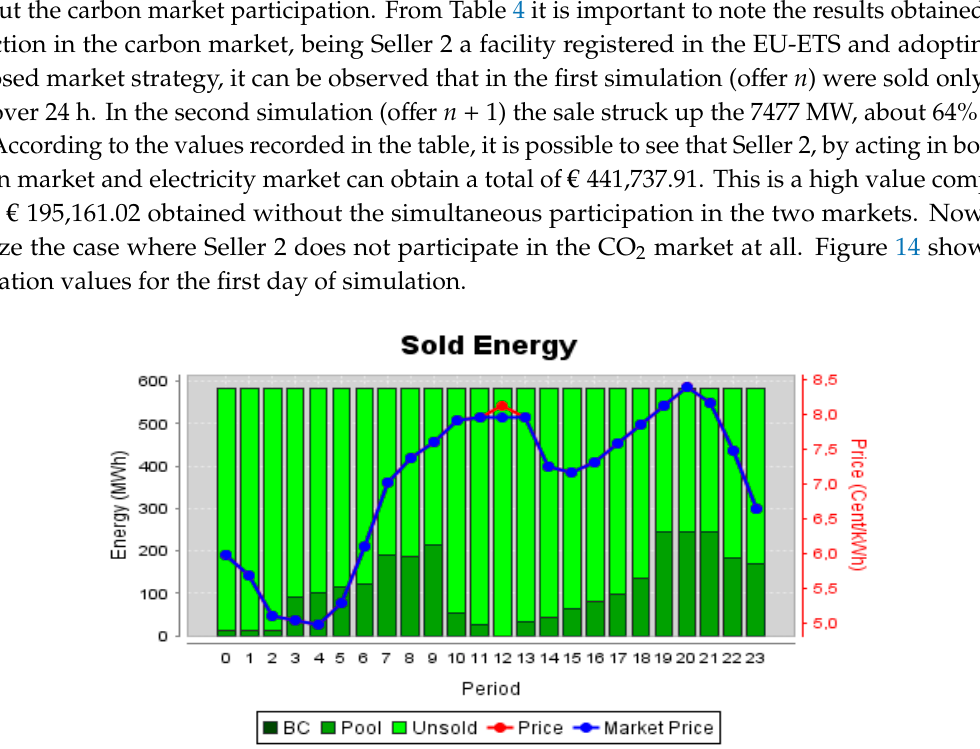
Figure 14. Energy sold on the market by Seller 2, when participating exclusively in the electricity market.